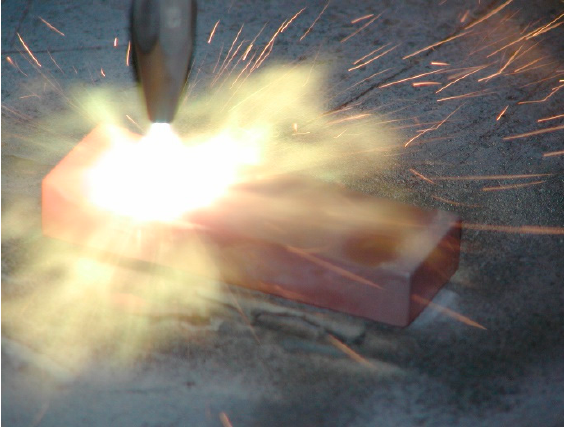
Figure 4. Flame spraying with simultaneous fusing—one-step process.